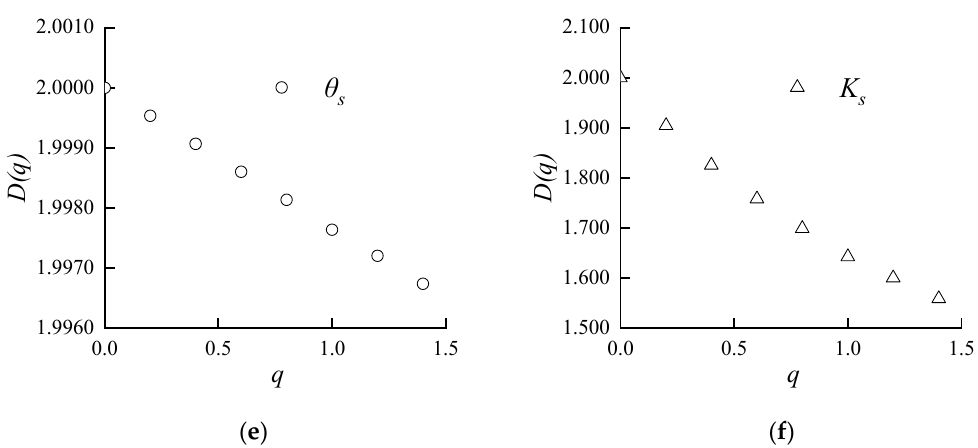
Figure 4. q–D ( q ) curve of soil properties in the study area. q —the order of statistical moment; D ( q )—the generalized fractal dimension.